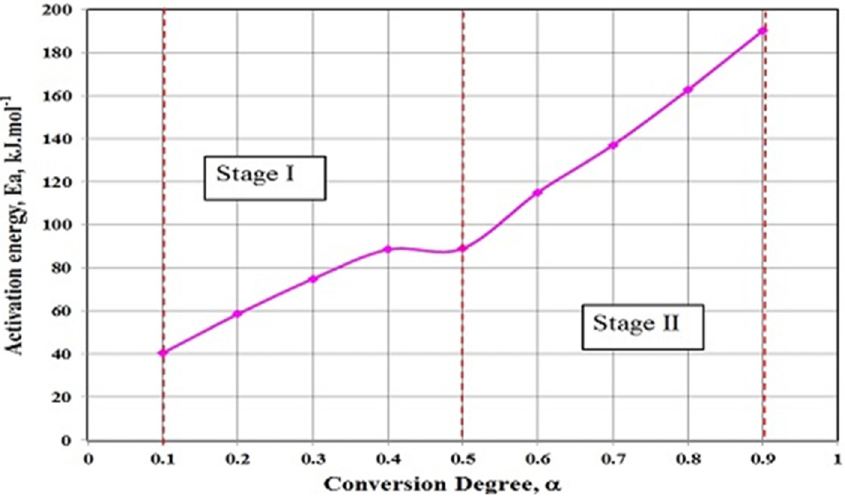
Figure 13. Calculated Ea against conversion degree for Fe 2 O 3 /charcoal composite.